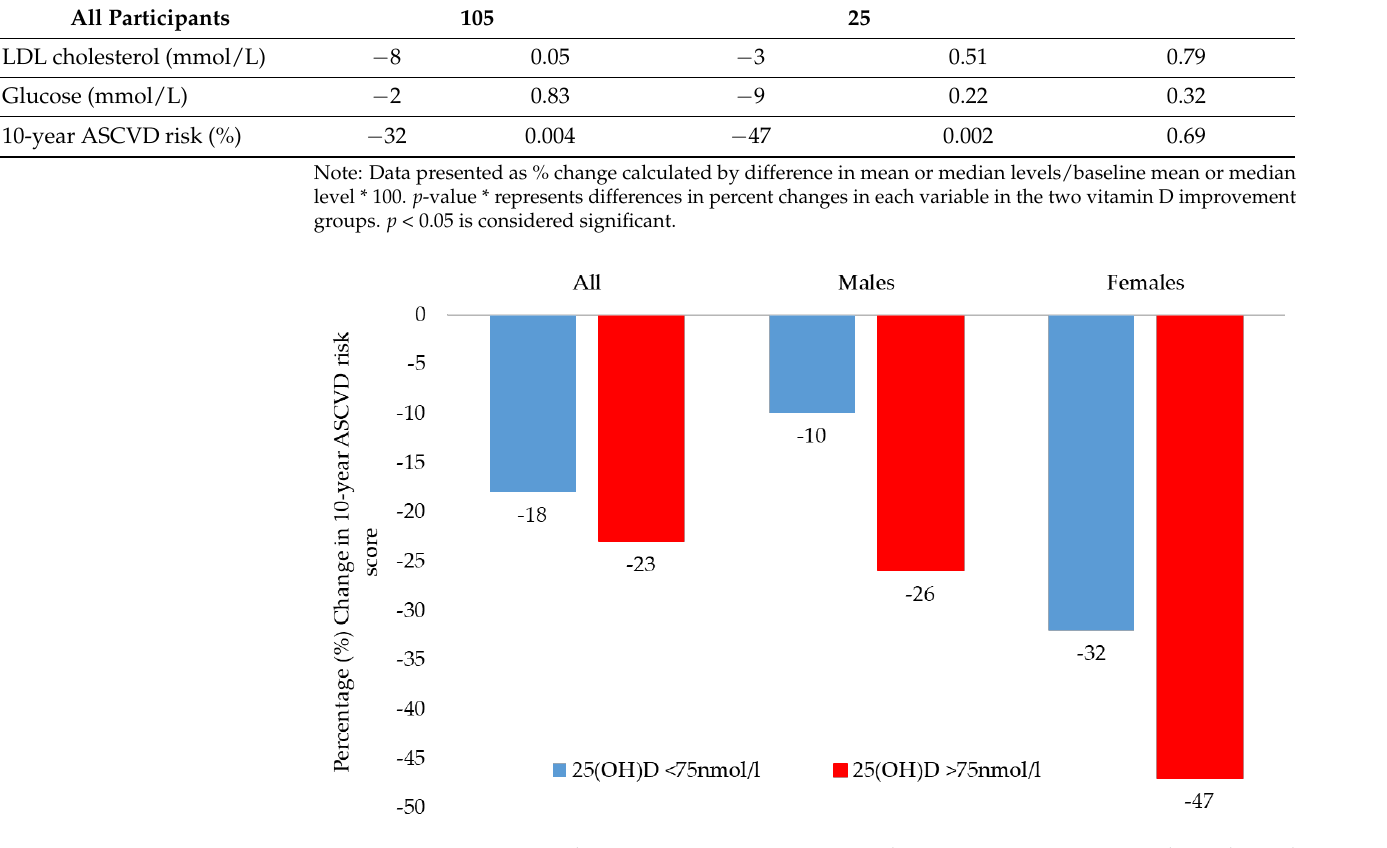
Figure 2. Percentage change in 10-year ASCVD risk score in participants who achieved 25(OH)D >75 nmol/L versus <75